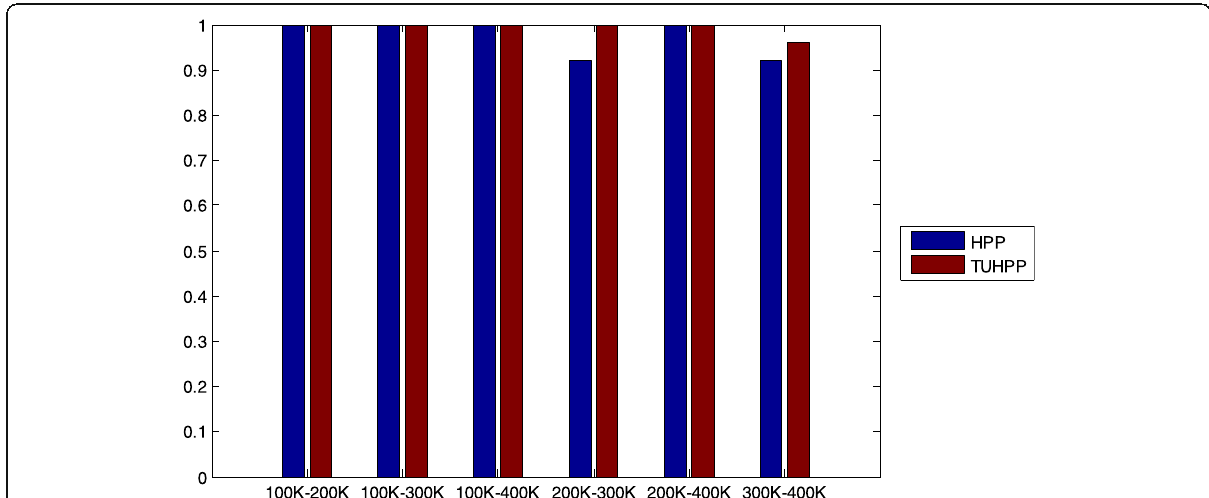
Fig. 9 The median value (MED) of detection accuracy of HPP [14] and